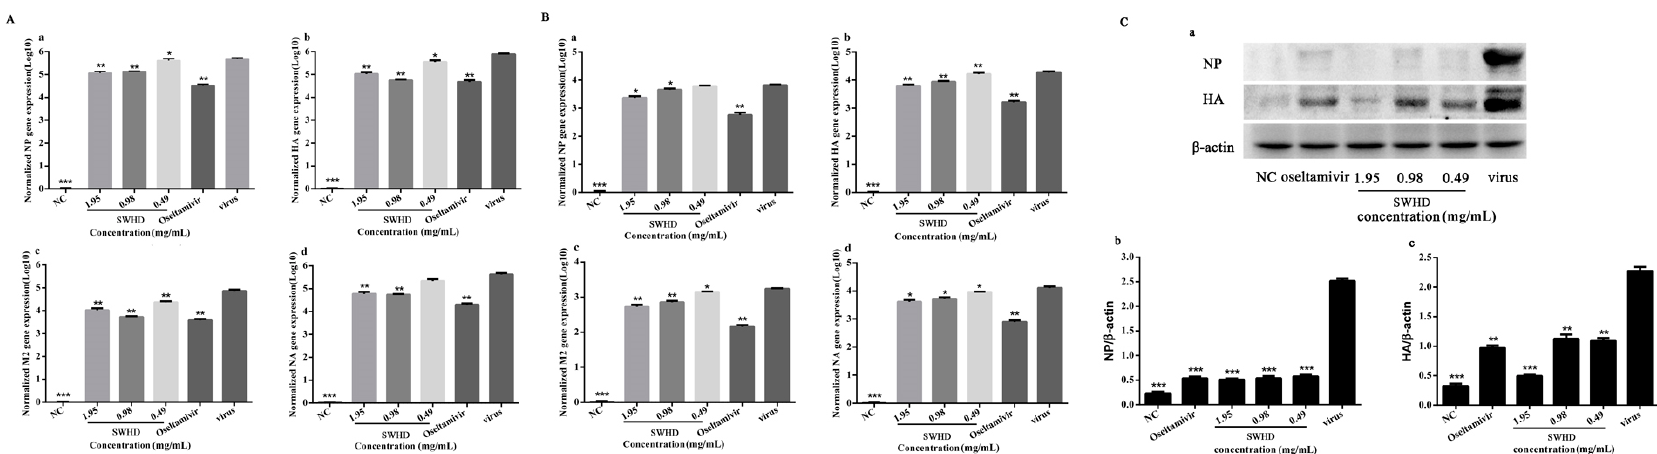
Figure 3. ( A , B ) The qPCR results of the quantification of viral mRNA expression of the four genes NP ( a ), HA ( b ), M2 ( c ) and NA ( d ) both in the MDCK cells ( A ) and supernatants ( B ). ( C ) The expression of the NP and HA proteins in the cells were detected by Western blot analysis ( a ). The inhibition effect of the NP ( b ) and HA ( c ) were calculated. The values are presented as the means ± S.D. of three individual experiments. * p < 0.05; ** p < 0.01; *** p < 0.001, when compared to the viral control.